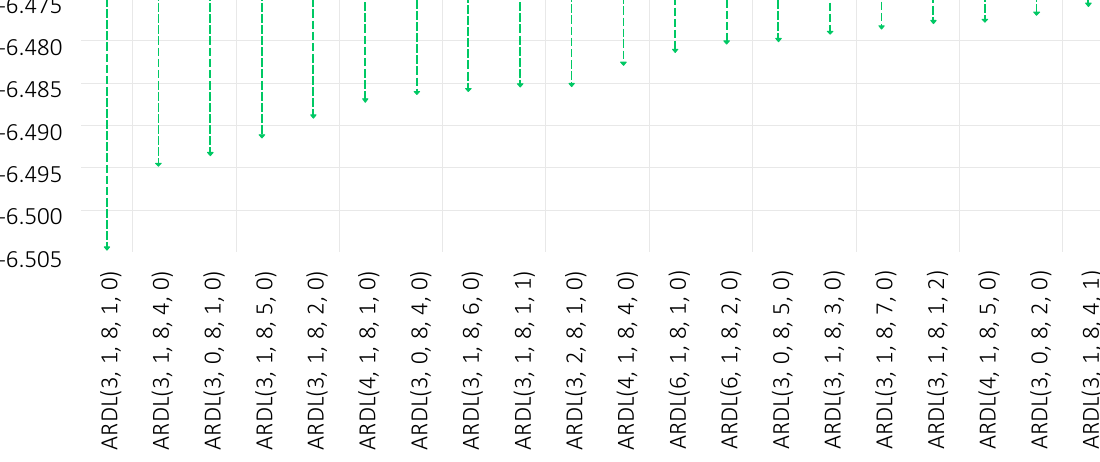
Figure 5. Akaike information criteria (top 20